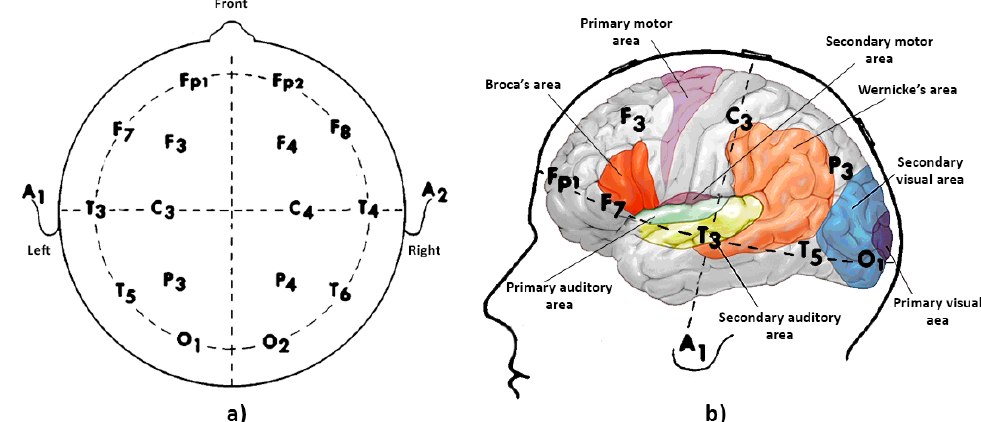
Figure 1. ( a ) Electrode configuration according to 10/20 international system used in the experiment. ( b ) Lateral view of the electrode configuration, compared with the brain areas (motor, auditory, visual, and